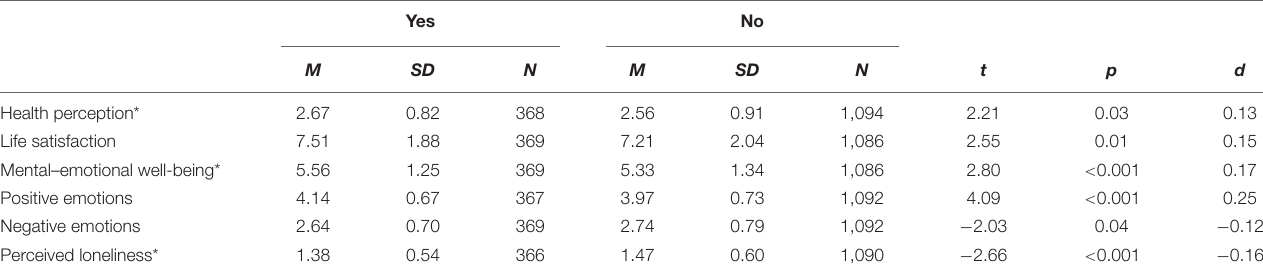
TABLE 3 | Comparison of means between older adults who are and are not members of neighborhood councils on hedonic health and well-being